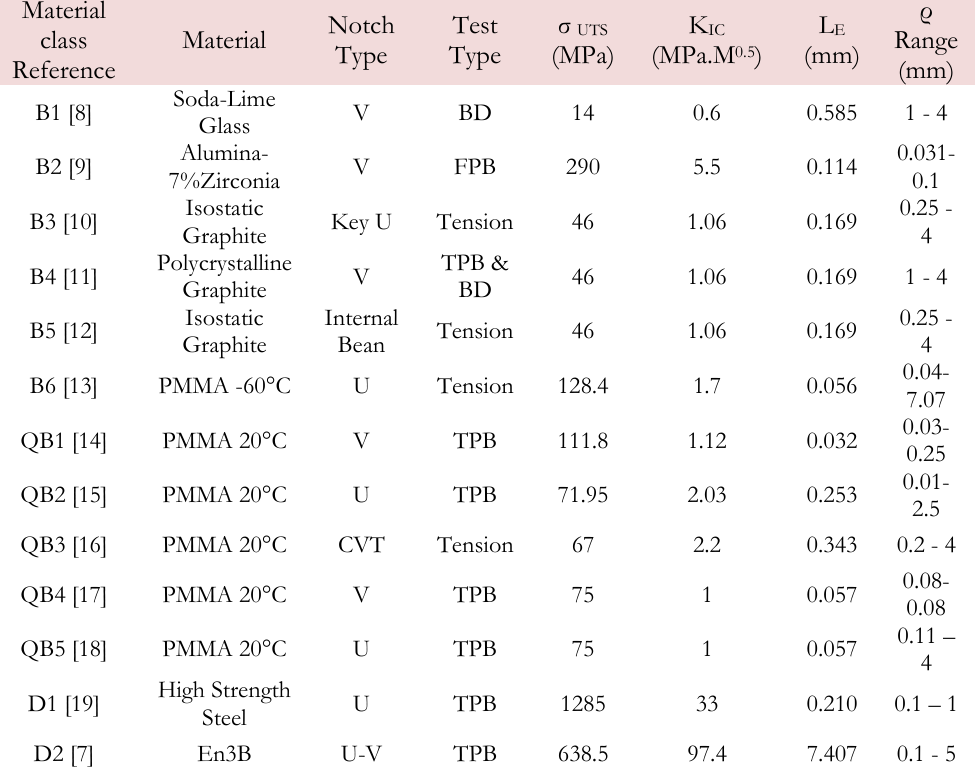
Table 1: Summary of experimental data (B=Brittle, QB=Quasi-Brittle and D=Ductile, BD=Brazilian Disk, TPB=Three Point Bending, FPB=Four-Point